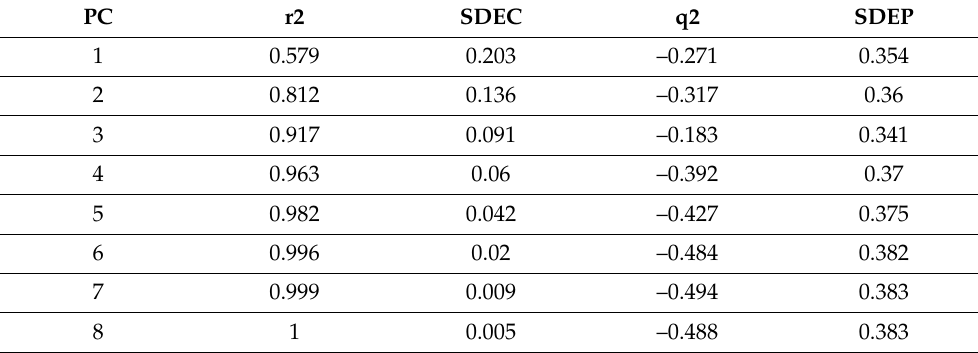
Table 9. Experimental values for the selected compounds .